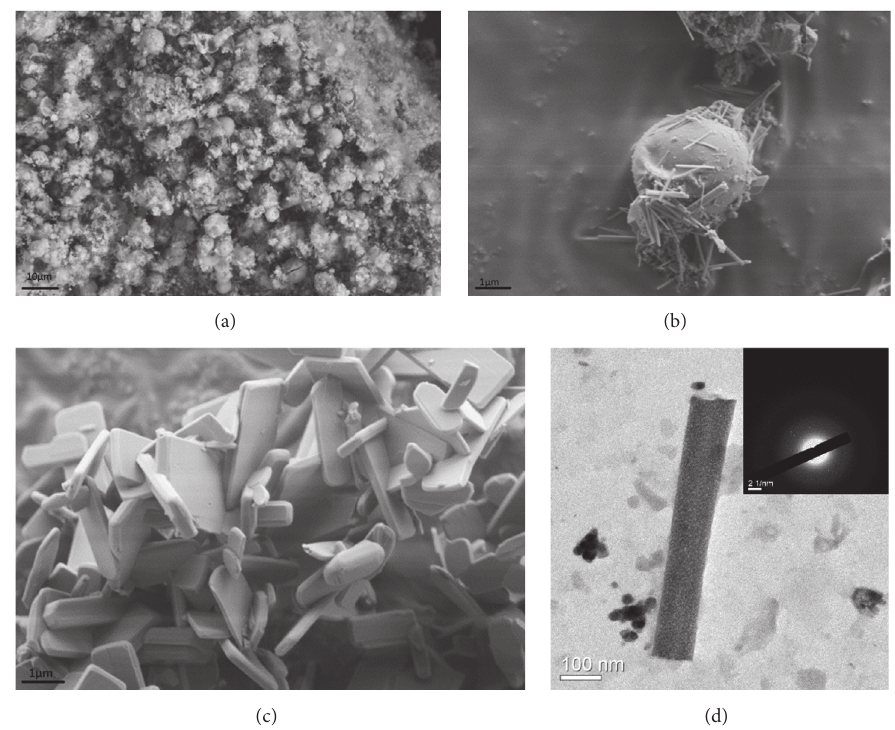
Figure 3: Scanning Electron Micrographs of (a) as-synthesized molybdenum particles. (b) High magnification image of as-synthesized molybdenum particles. (c) Molybdenum particles after thermal treatment. (d) TEM image of nanorods in as-synthesized samples.